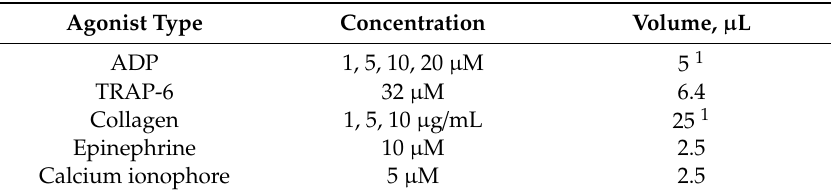
Table 2. Final concentrations and aliquot volumes of biochemical agonists used to induce platelet aggregation in the MICELI